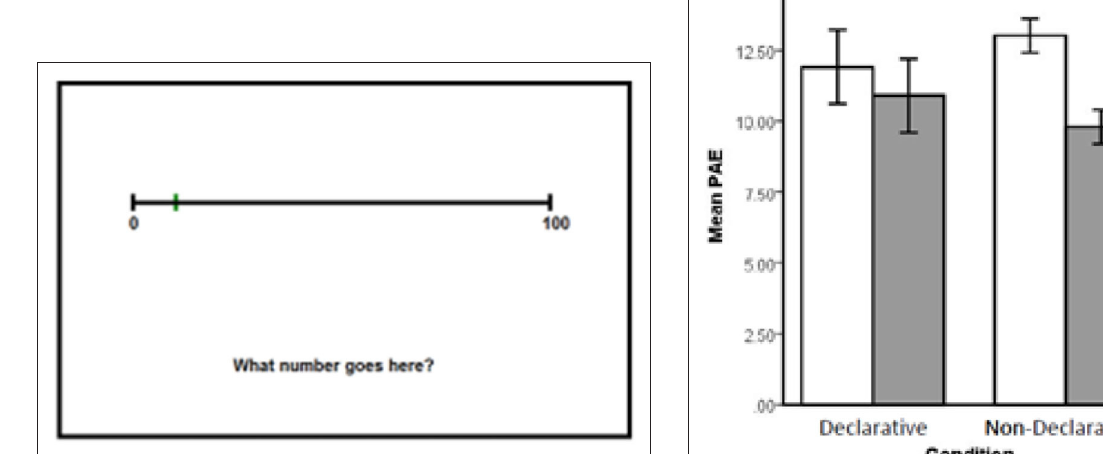
FIGURE 3 | Stimuli for the pre-test and post-test tasks. Participants are given a single point on a number-line and must type the symbolic number which matches the position of the point.